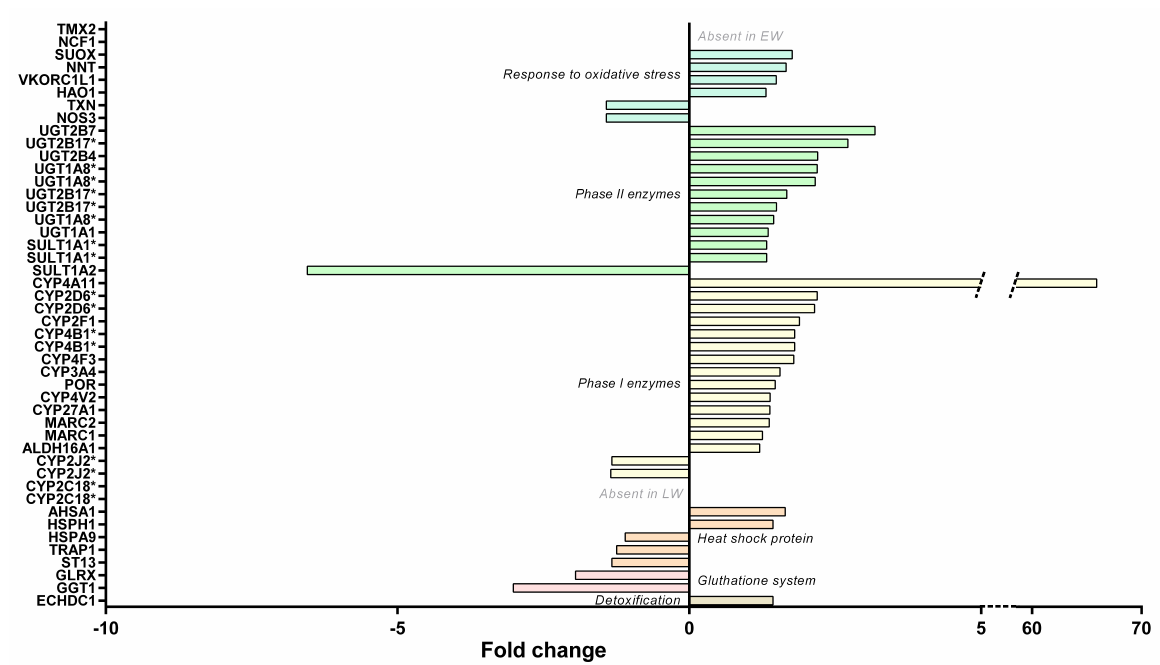
Figure 7. Regulation of liver stress responses in grey mouse lemurs during winter. The relative abundance of liver proteins involved in liver detoxification, oxidative stress and that of heat shock proteins in early (EW) and late (LW) winter mouse lemurs (N = 5/group) are shown using mean fold changes in LW vs EW. The presence of several isoforms of the same protein are indicated with asterisks